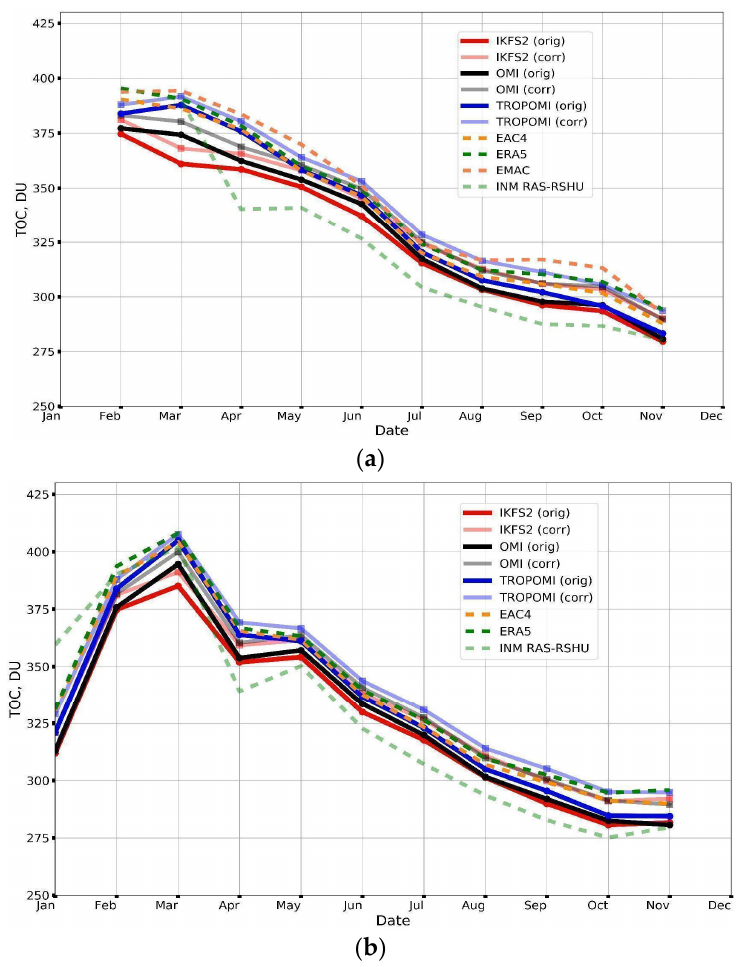
Figure 7. Seasonal variability of TOCs near St. Petersburg according to the satellite observations and simulated data with (( a ), 2019–2019) and without (( b ), 2018–2019) EMAC.